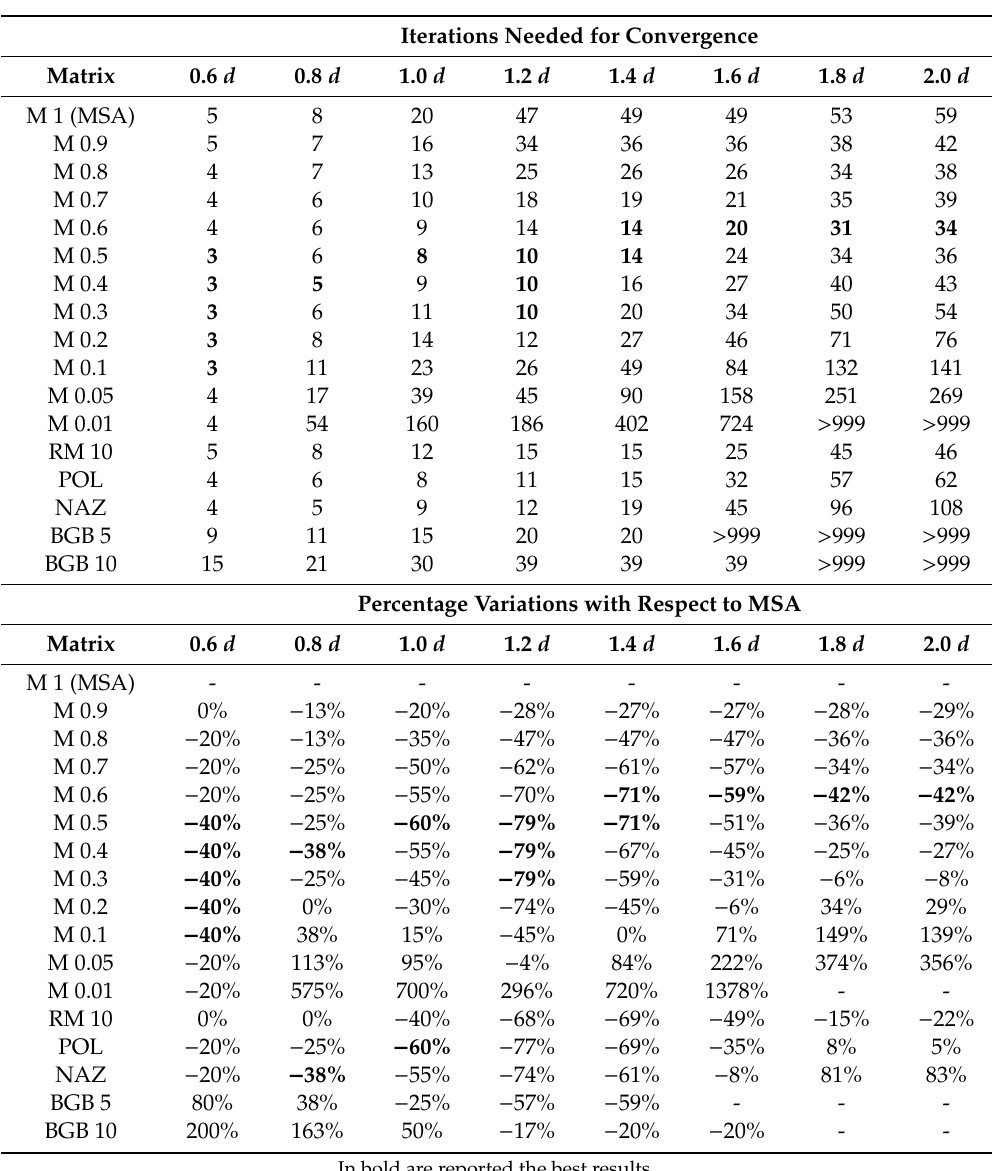
Table A1. Comparison among MSA-based